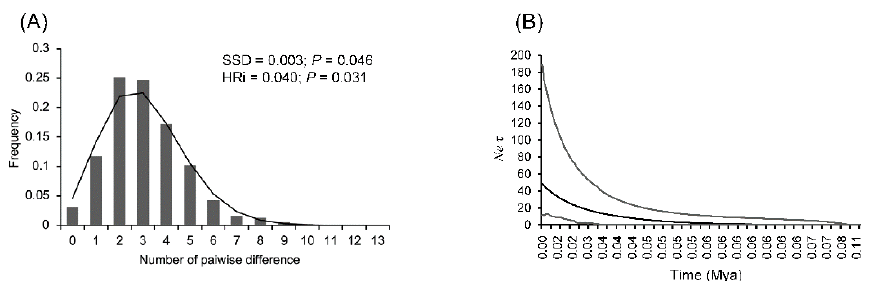
Figure 7. Mismatch distribution ( A ) and extended Bayesian skyline plots ( B ) of the hilly lineage of NSC inferred from COI + 16S rRNA genes. Statistical results are shown in the panel.